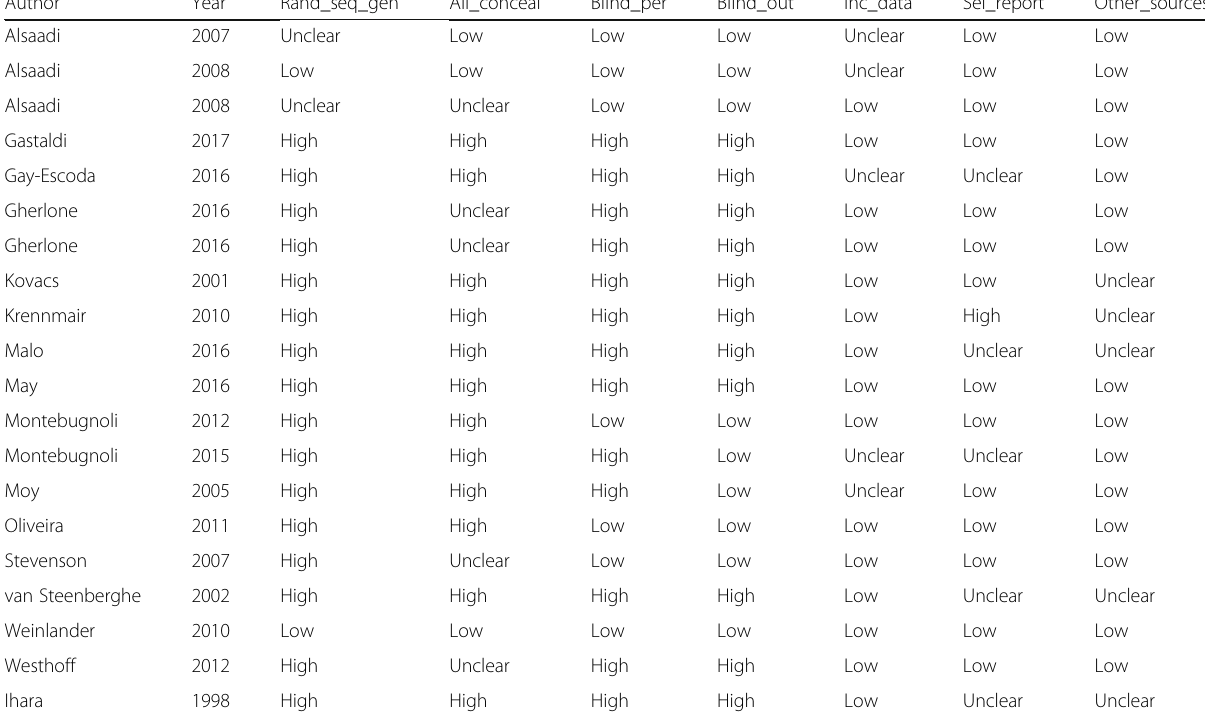
Table 1 Risk of bias